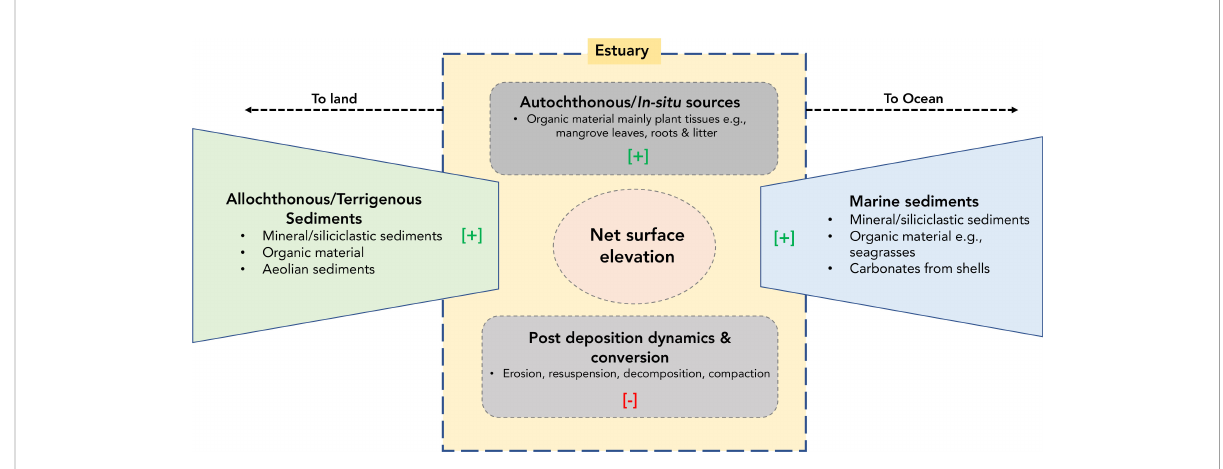
FIGURE 2 Conceptual model of the biophysical processes that control the localized net surface elevation in mangroves. [+] indicating positive/incremental (accretion) in fl uence while [-] indicate a negative (subsidence, loss of surface elevation) in fl uence.